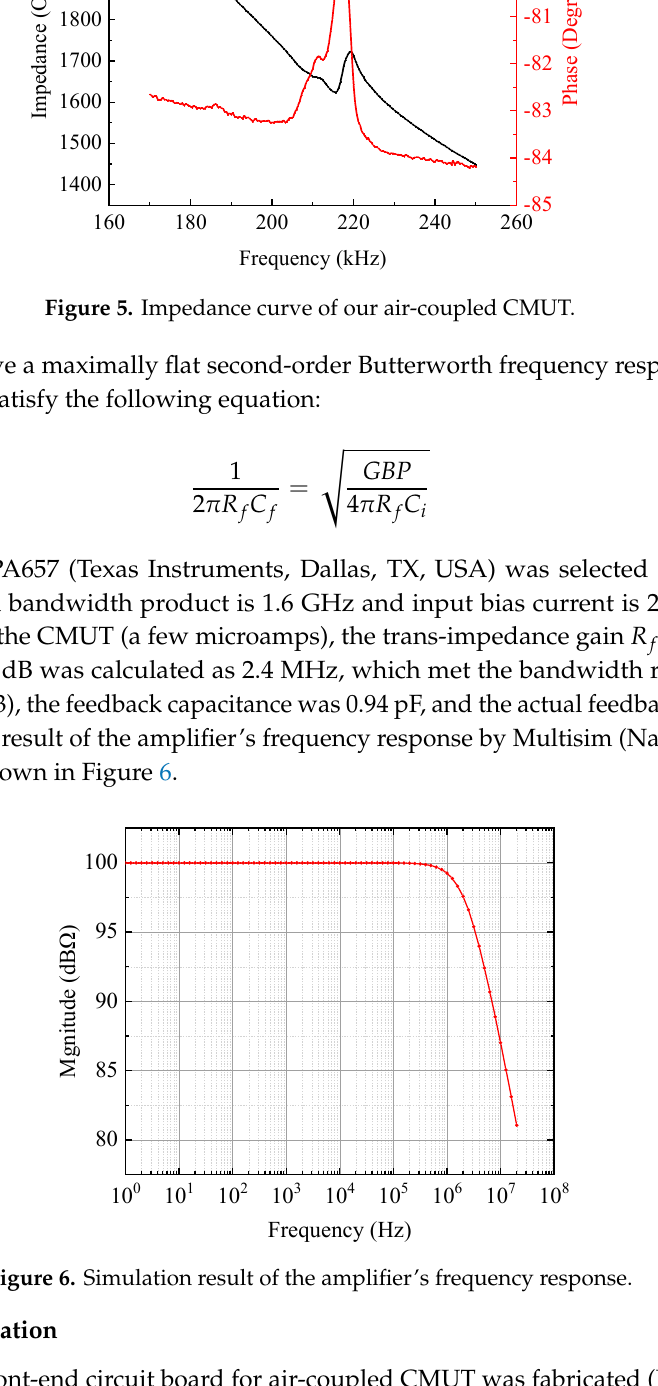
Figure 6. Simulation result of the amplifier’s frequency response.